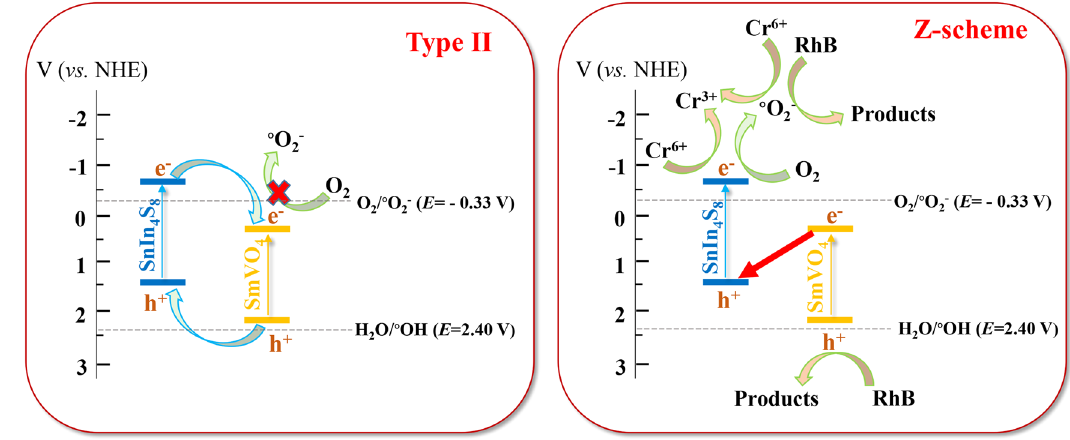
Fig. 10 Mechanism of the photocatalytic process. Two default con fi guration for studied heterojunction